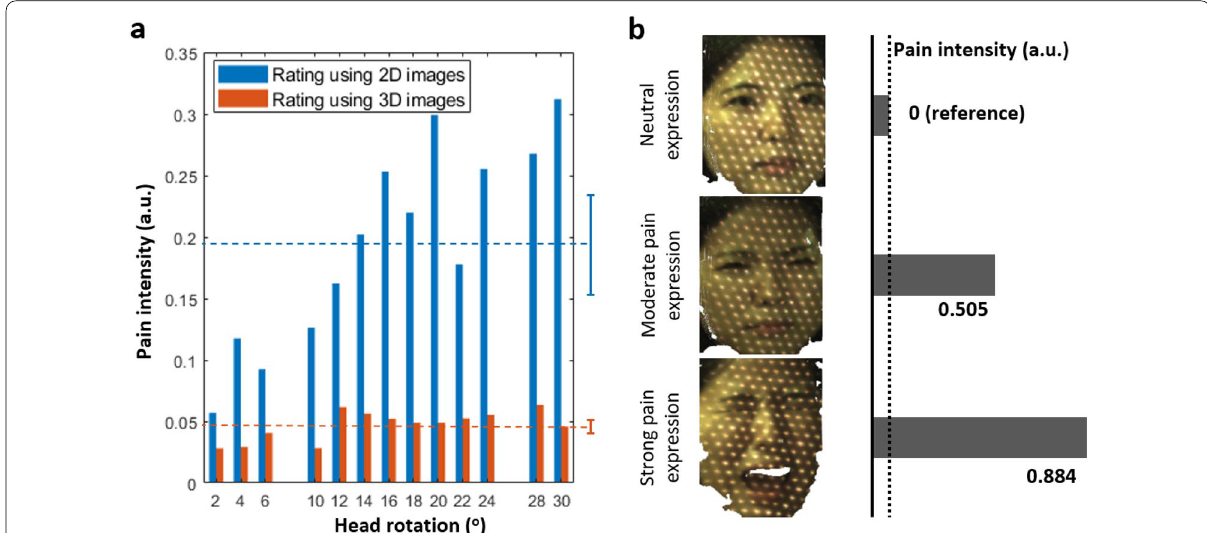
Fig. 5 Measured pain ratingwith the FRCM. a Comparison of the pain rating obtained from 3D and 2D imagingdepending on the rotational angle of a plaster cast. The pain intensitiesobtained from 3D images (mean: 0.047, std.: 0.012) is more consistent painintensity than those from 2D images (mean: 0.196, std. 0.078). b Measured pain intensityobtained from 3D images of human facial expression. The strong expressions exhibitthe highest